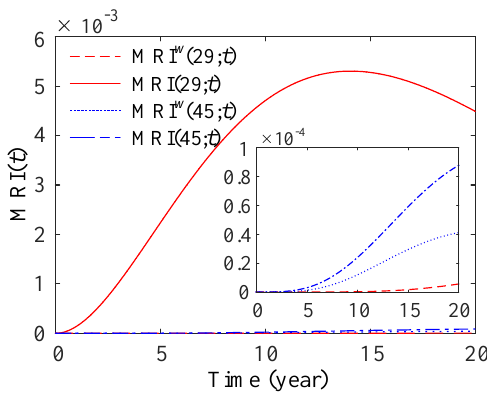
Figure 14. MRI of components (29 and 45) with and without swapping.